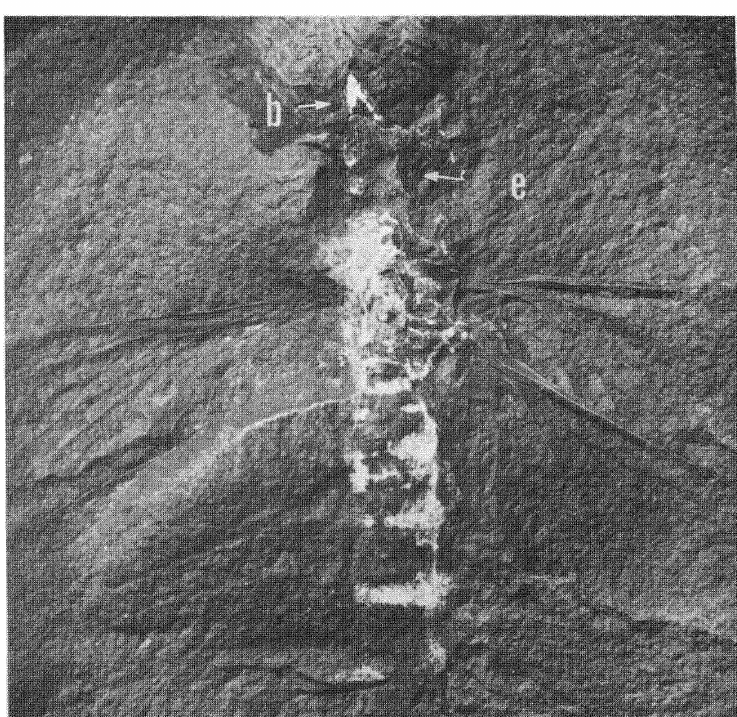
Figure 4. Eubleptus danielsi. Photograph of specimen 236, Daniel Damrow collec- tion; dorsal view of thorax, but frontal view of head: b, beak; e, eye. The three thoracic segments are partially covered by kaolinite. Maximum width of fore wing in photograph, 3.5